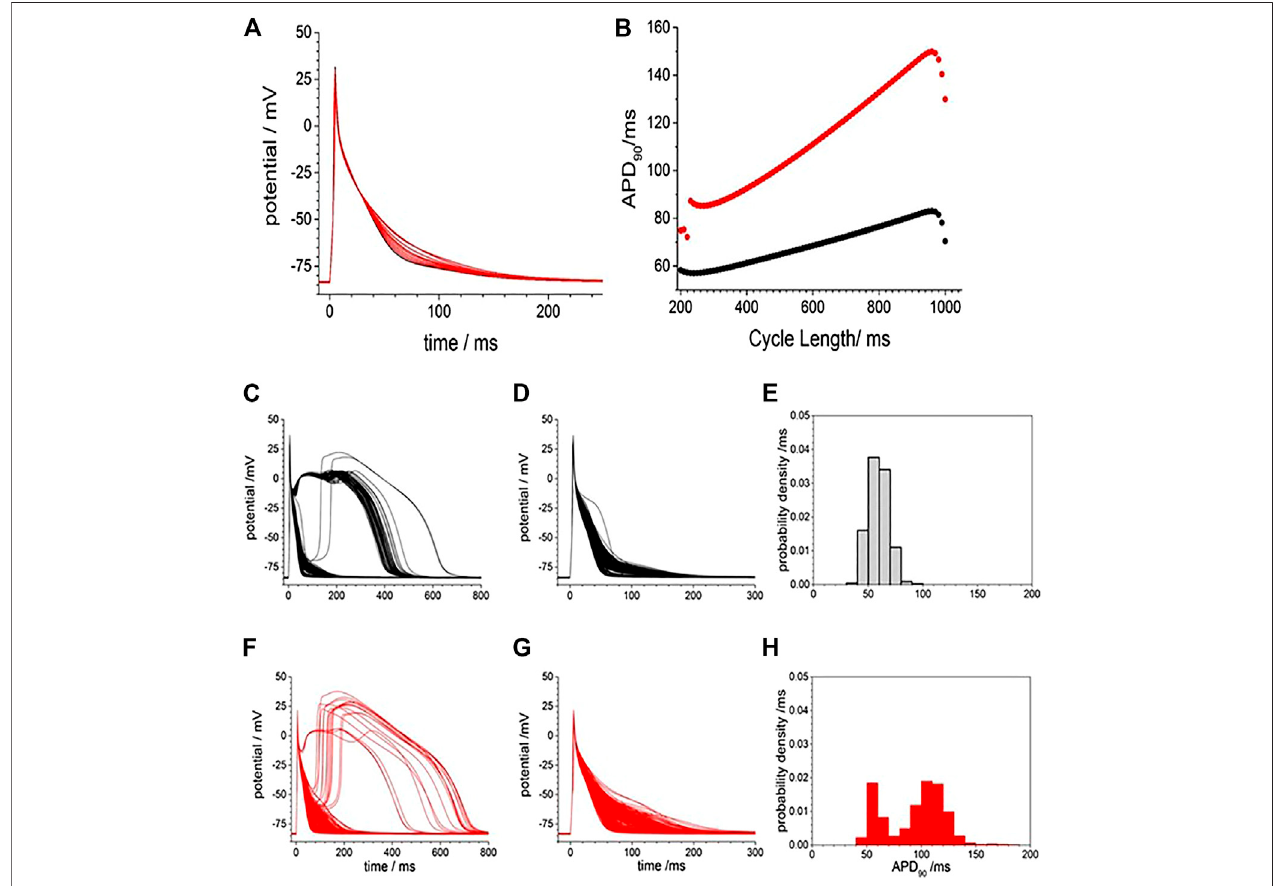
FIGURE 2 | Gattoni et al. model generated potentials increased in duration and variability with CO. (A) , smooth prolongation of action potential produced by scaling, by 0 – 100%, of the CO conductance effects. Periodic action potentials, BCL 1000 ms, after 100 cycles of pacing; (B) Dynamic APD 90 restitution curve showing theeffectsofCO(red)whencomparedwithstandardparameters(black).APDvariabilitywithstandardmodel(black)andwithCOparameterchanges(red)andGaussian distributed mean parameters with ± 5% variability in all model conductance parameters (C) . 500 action potentials produced after 50 cycles with BCL 950 ms (D) . Action potentials and (E) probability density estimate for APD 90 after atypical action potentials with APD 50 > 100 ms excluded (F – H) as in (C – E) with mean parameters for